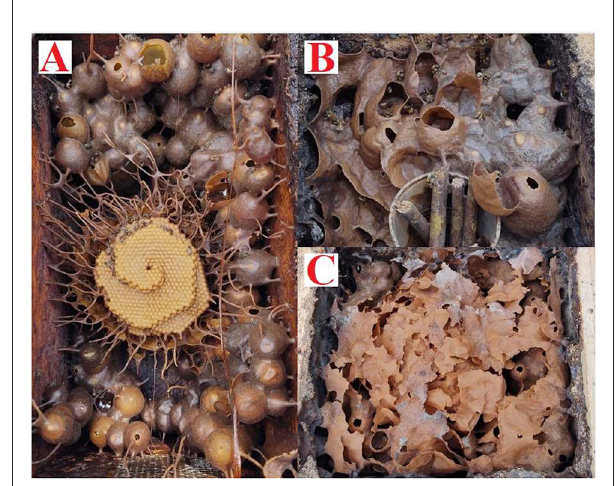
FIGURE3 Honeycombs of Plebeia llorentei (A) , Melipona beecheii (B) , and Scaptotrigona pectoralis (C)